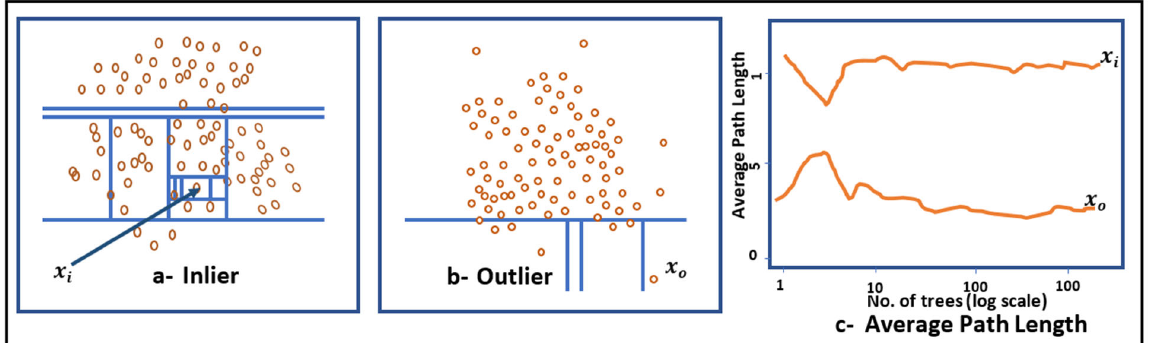
Figure 13. An inlier ( x i ) in ( a ) needs a more splits than an outlier ( x 0 ) in ( b ) to isolate. ( c ) shows each point’s average length.